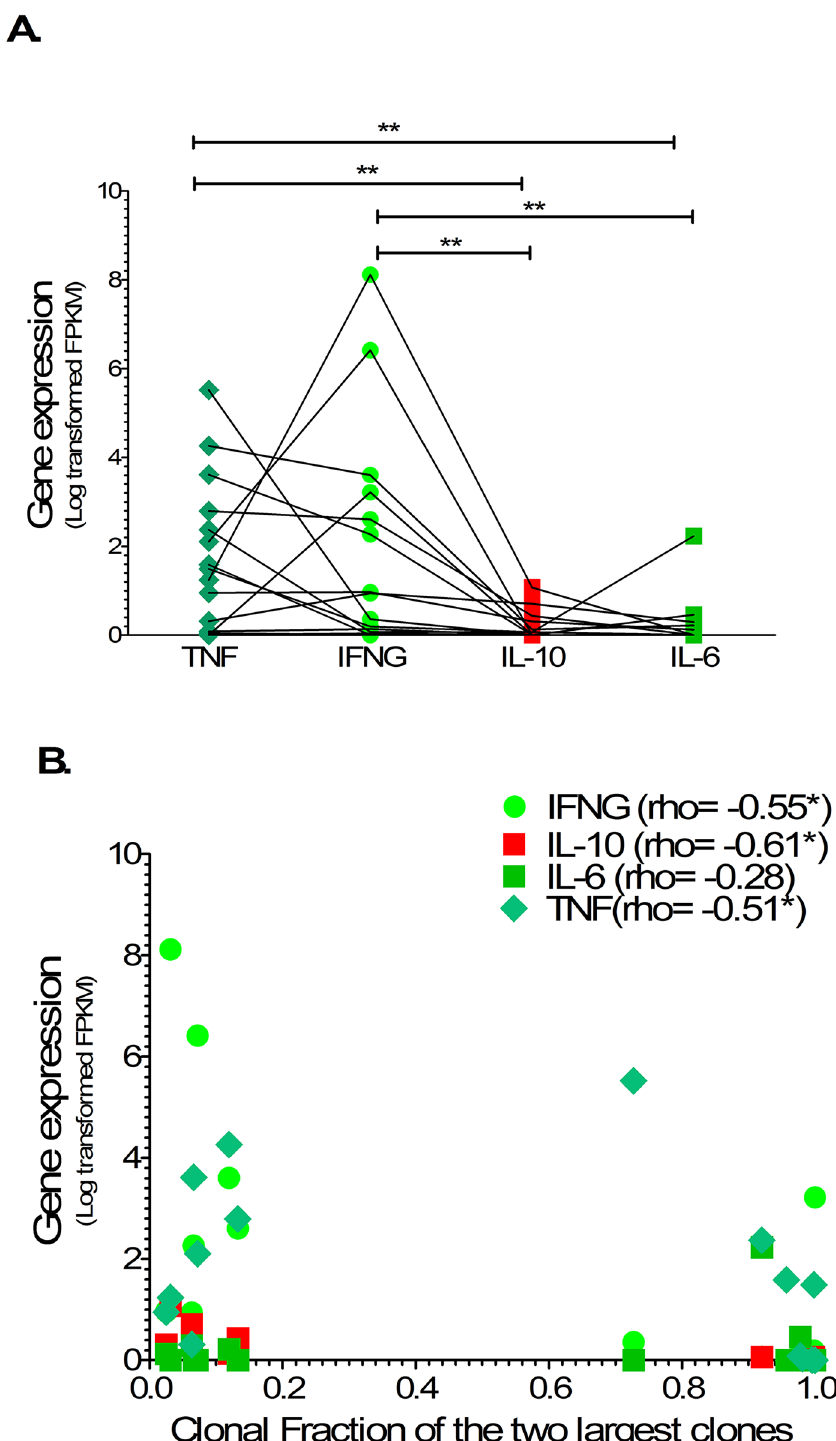
Fig 7. Cytokine mRNA expression profile in non-malignant HTLV-1 infection and ATL. Column plots (A) shows normalized FPKM expression of TNF, IFN, IL-6 and IL-10 linked by patient samples. Statistical analysis: Kruskal- Wallis test with Dunn post-test, 95% confidence interval and Wilcoxon signed rank test. Scatterplot (B) shows correlation between normalized FPKM expression and clonal fraction of two largest clones. Statistical analysis: Spearman correlation. (cid:3) denotes p < 0.05, (cid:3)(cid:3) denotes p < 0.01, (cid:3)(cid:3)(cid:3) denotes p < 0.001.